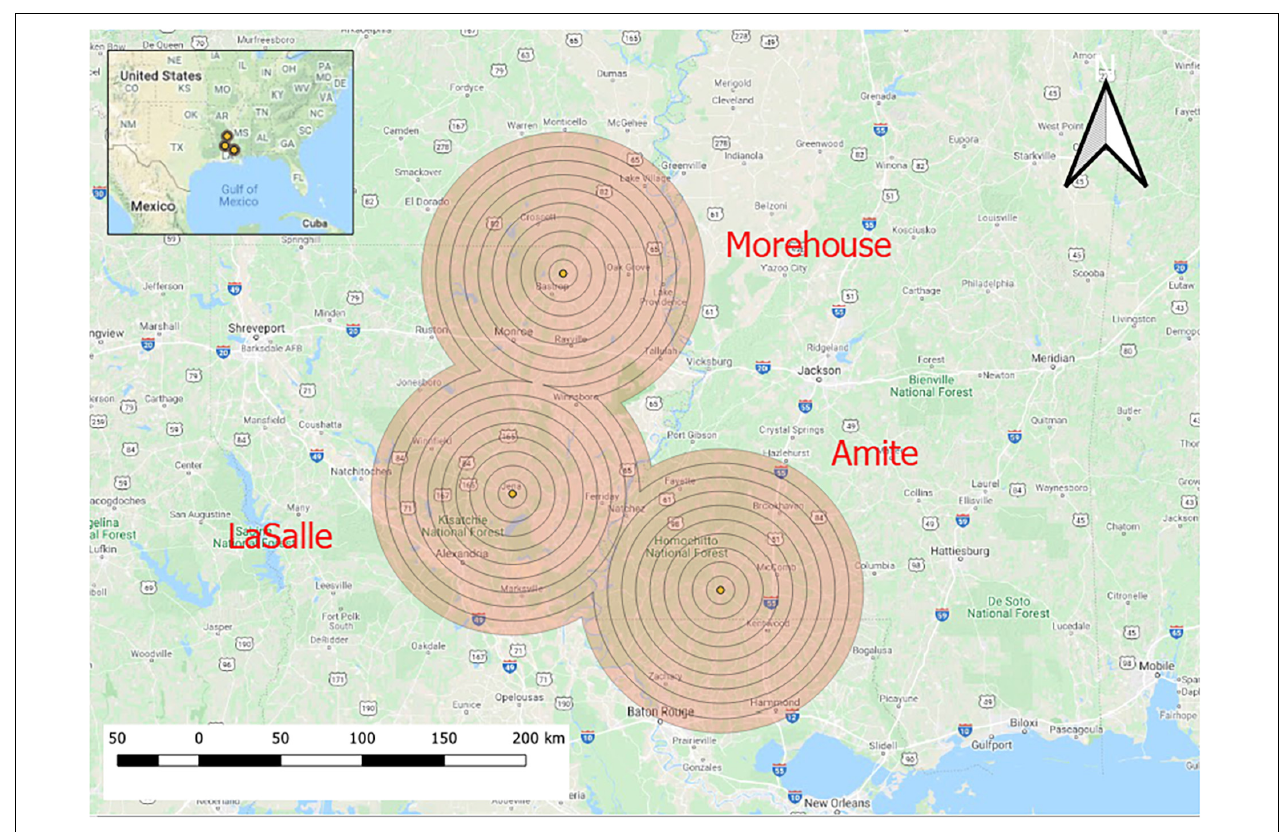
FIGURE 1 | Drax pellet plant locations in Louisiana and Mississippi with an 80 km supply radius.